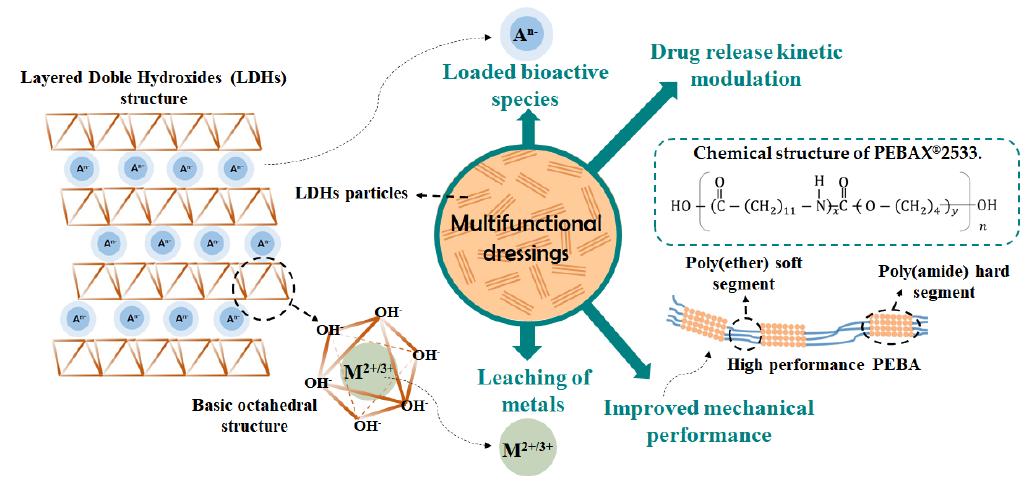
Figure 1. Schematic representation of the designed multifunctional dressings, its multiple components, and the schematic representation of the general structure of layered double hydroxide (LDH) and polyether (PE) and polyamide (PA), also known as PEBA, polymer.